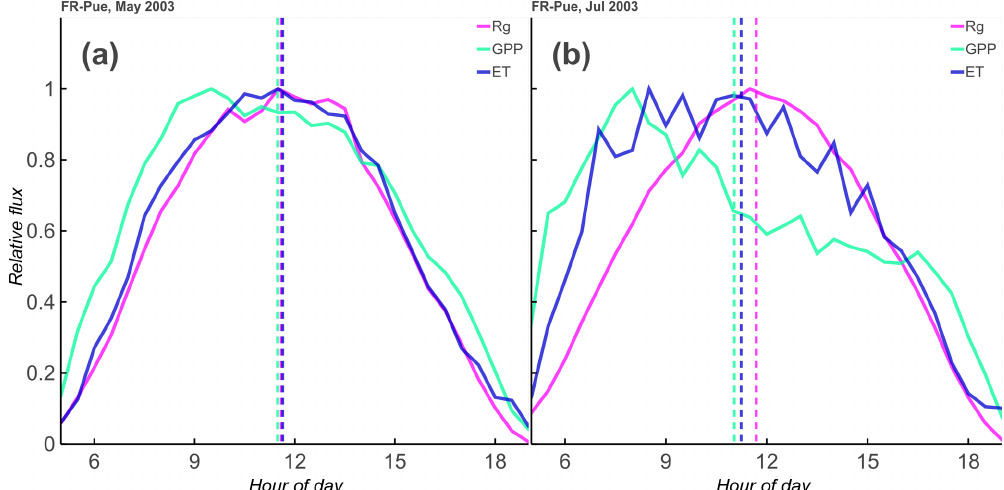
Figure 1. One-month average cycle (solid lines) and accompanying diurnal centroid (vertical dashed lines) of incoming shortwave radiation ( R g ), evapotranspiration (ET), and gross primary productivity (GPP) at the Puéchabon, France (FR-Pue), site during 2003. May is relatively wet (32mm rainfall, a ) and July is relatively dry (0mm rainfall, b ). While ET and R g correspond well in the wet month, the dry month shows a distinct phase shift in both GPP and ET fluxes towards the morning, as well as a midday depression in